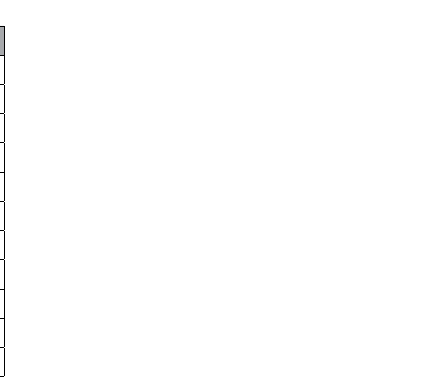
Table 3. Weight average (Mw) and number average (Mn) molecular weights, and polydispersity (P), as calculated from UV-detected HPSEC chromatograms for HA-LIG and HA-CYN, before and after addition of acetic acid (AcOH). Standard deviation was <